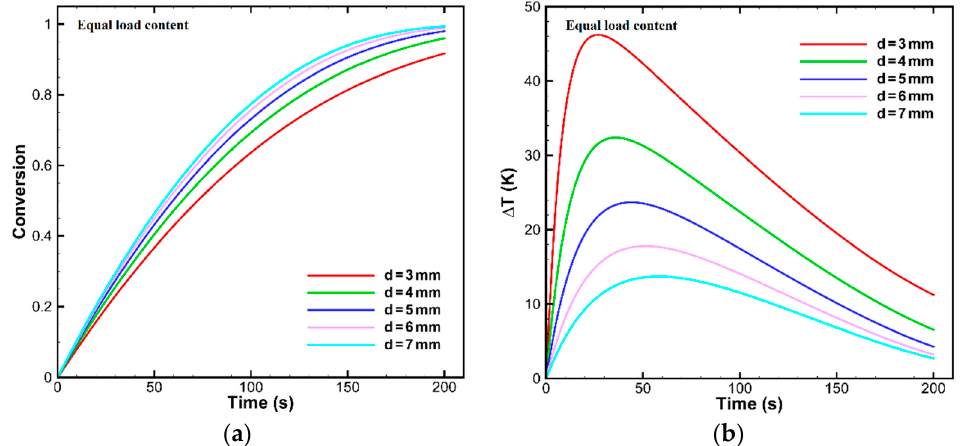
Figure 7. The profiles of ( a ) overall conversion and ( b ) ∆ T with various particle sizes in the equal active load content over time.